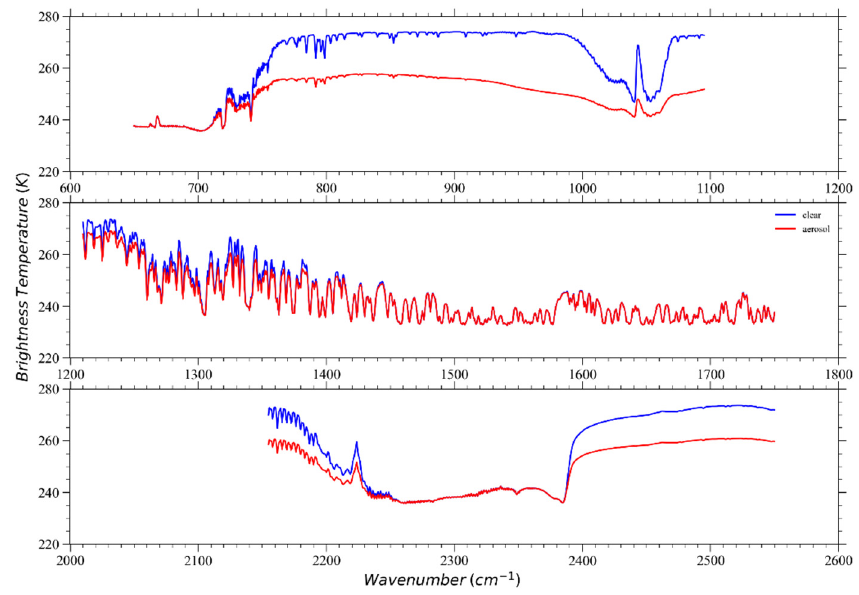
Figure 2. The simulated brightness temperatures of the CrIS LWIR ( upper panel ), MWIR ( middle panel ), and SWIR ( bottom panel ) band under the clear-sky (blue curve) and dusty (red curve) condition (with sand aerosol profile).